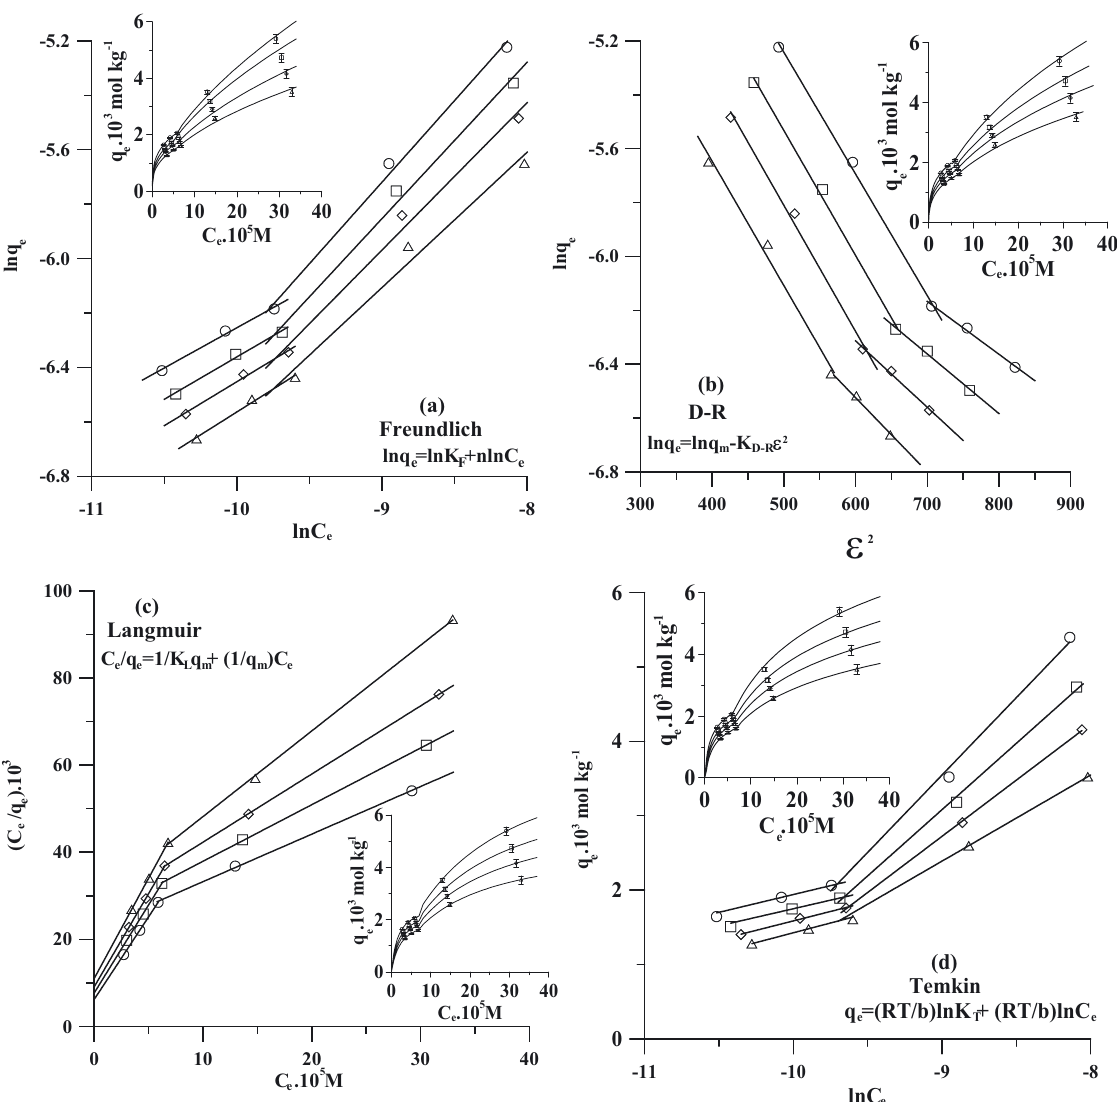
Figure 2. Linearized a) Freundlich -, b) D-R -, c) Langmuir-, and d) Temkin isotherm plots of MCPA adsorption on the BS at different temperatures: ( Δ ) 298 K, (  ) 308 K, (  ) 318K and (  ) 328 K. a) Theoretical isotherm curves are compared to experimental points in the insets of the